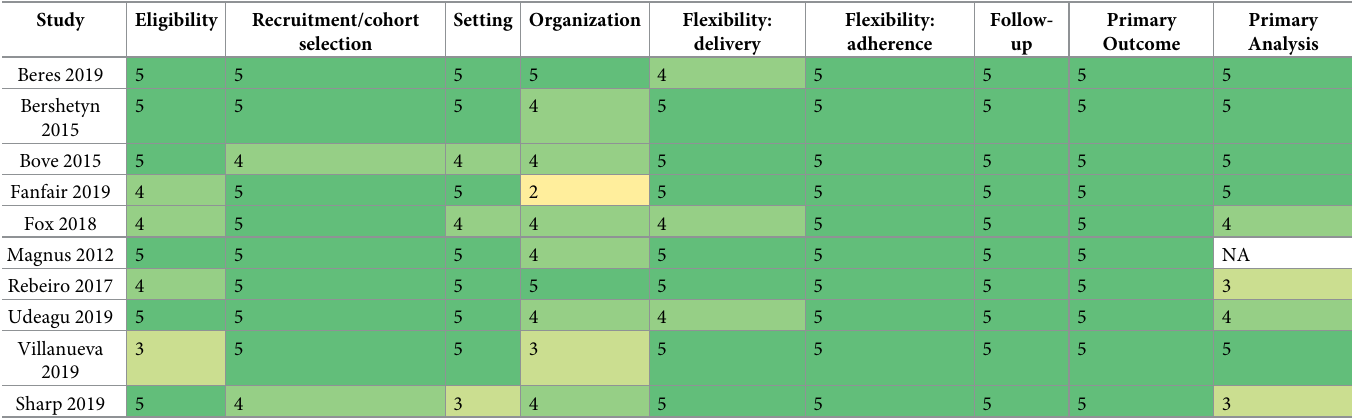
Table 5. PRECIS criteria/score.